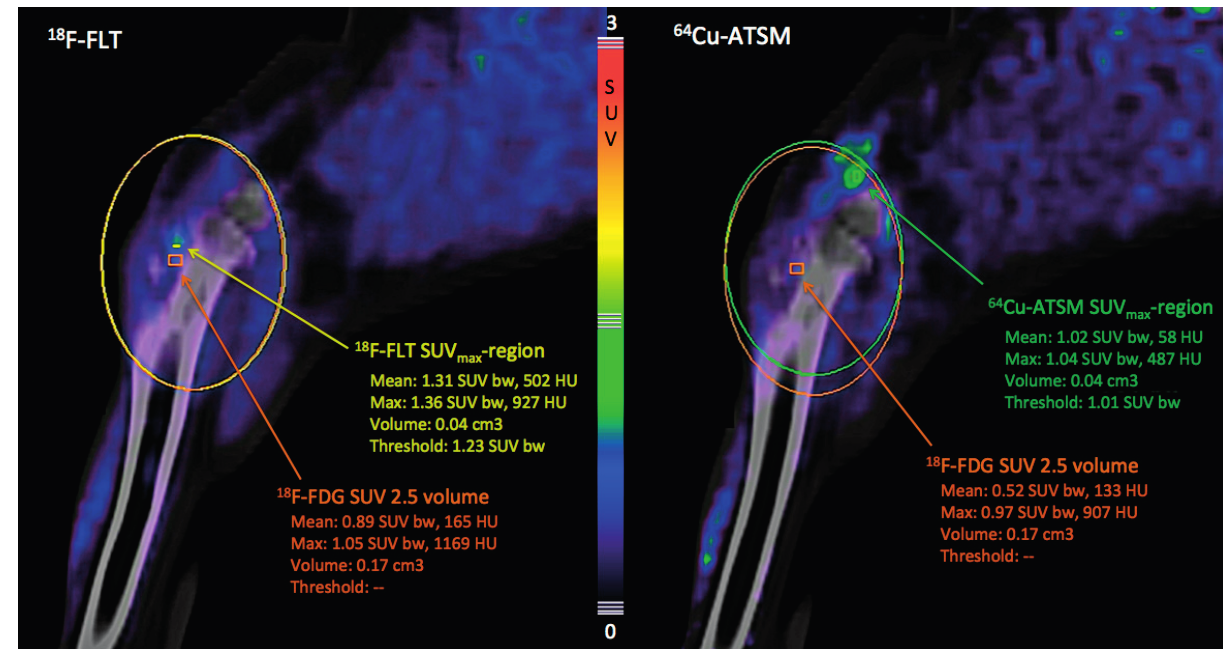
Figure 2. PET/CT images of the tumor area in the left proximal tibia, sagittal plane, 10 weeks after completion of radiotherapy. The SUV max -region for 18 F-FLT (left picture) and 64 Cu-ATSM (right picture) are localized outside the 18 F-FDG SUV 2.5 volume. Orange rectangles demarcate 3D iso-contouring lines for the tumor volume of interest (VOI) defined by a standardized uptake value (SUV) cut-off at 2.5 for 18 F-FDG ( 18 F-FDG SUV 2.5 volume). The maximum and mean SUV values for the respective tracers in this VOI are given in orange text. The yellow rectangle demarcates 3D iso-contouring lines for the 18 F-FLT SUV max region. This is a region defined by 90% of the maximum SUV for 18 F-FLT in the tumor area. The maximum and mean SUV values for 18 F-FLT uptake in this SUV max -region are given in yellow text. The green rectangle demarcates 3D iso-contouring lines for the 64 Cu-ATSM SUV max region. This is a region defined by 90% of the maximum SUV for 64 Cu-ATSM in the tumor area. The maximum and mean SUV values for 64 Cu-ATSM uptake in this 64 Cu-ATSM SUV max region are given in green